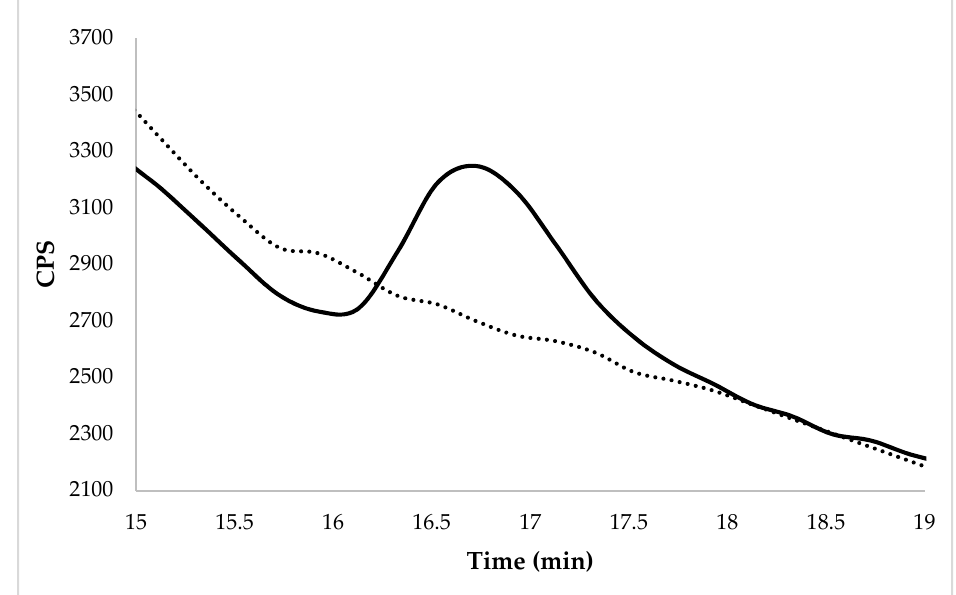
Figure 2. Chromatogram of WR (Caravaggio variety) at the spiked level of 0.01 mg kg − 1 by HPLC- ICP-MS/MS. The dotted line represents the same un-enriched sample.